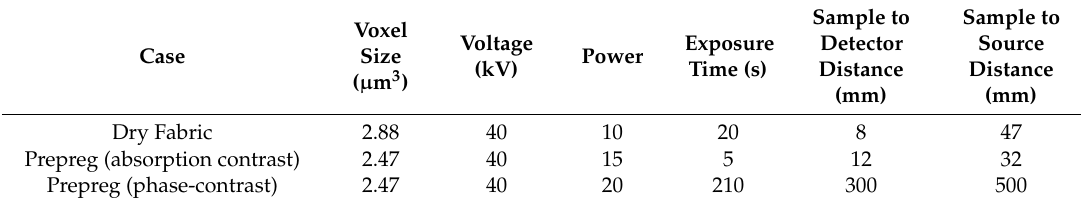
Table 2. Scan parameters used for three imaging cases